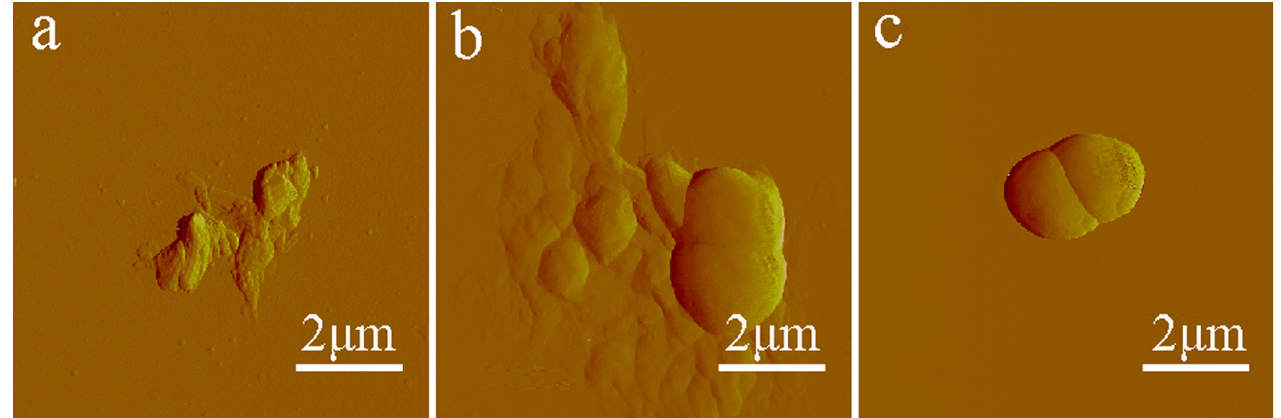
Fig 8. Atomic force microscopy images of Pseudomonas aeruginosa . P . aeruginosa was exposed to (a) protoporphyrin IX–ethylenediamine derivative (PPIX-ED)–mediated photodynamic antimicrobial chemotherapy (PACT), (b) PPIX-ED with no light (b), or (c) no treatment (control group).